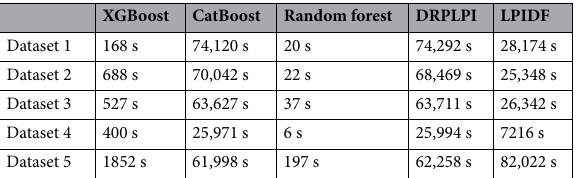
Table 9. The time required for all LPI prediction methods. Where s denotes second.